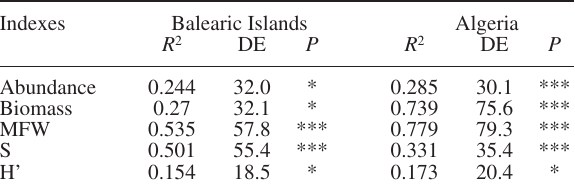
Table 6. – Summary of GAM’s modelling the relationship of the community descriptors with depth, by area. Abbreviations, units and P -values are given as in Table 5. R 2 , R squared; DE, percentage of deviance explained. Indexes